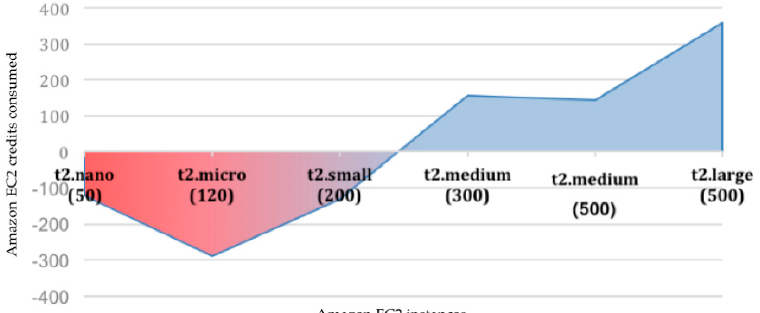
Figure 11. Graphical representation of difference between Amazon EC2 CPU credits offered by upfront payment for reserved Linux instances (type t2).